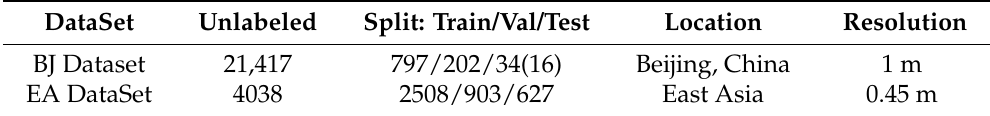
Table 1. The basic information of the